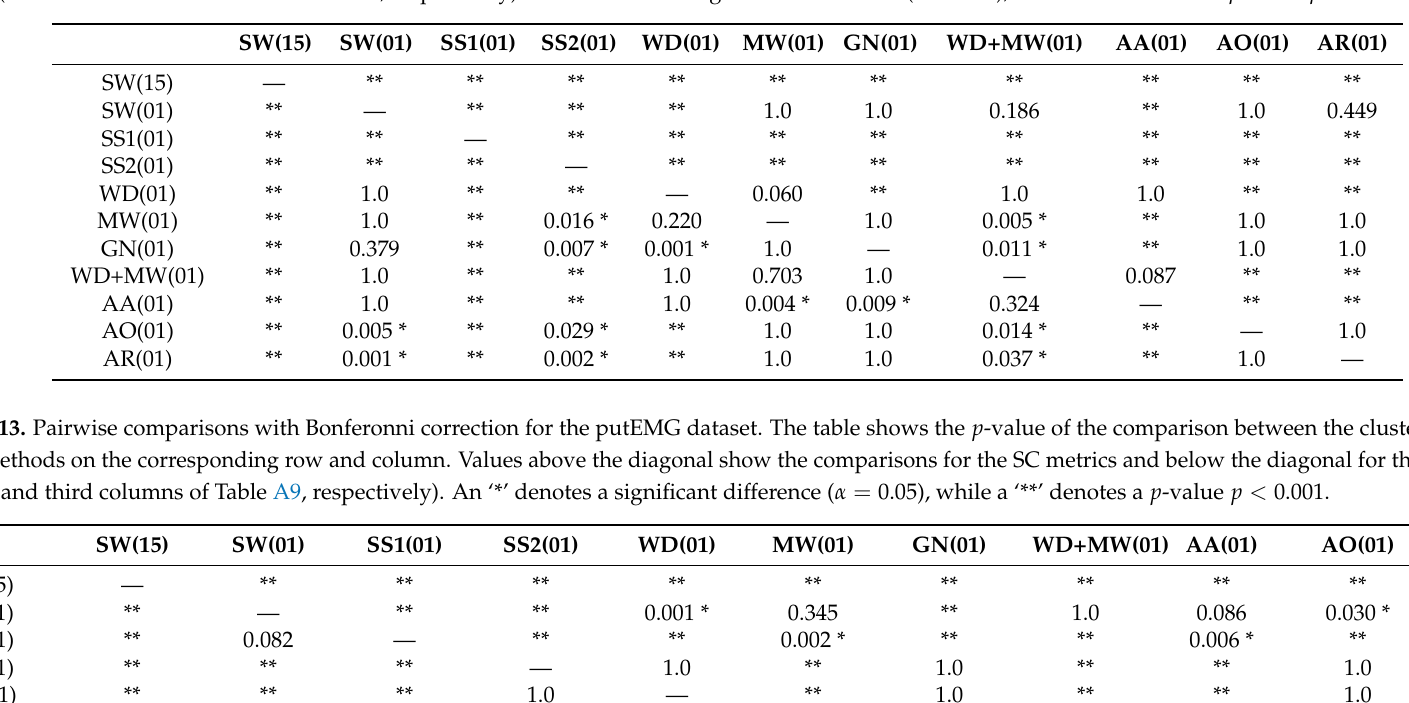
Table A12. Pairwise comparisons with Bonferonni correction for the Ninapro-DB1 dataset. The table shows the p -value of the comparison between the clustering metrics of the methods on the corresponding row and column. Values above the diagonal show the comparisons for the SC metrics and below the diagonal for the DB metrics (second and third columns of Table A8, respectively). An ‘*’ denotes a significant difference ( α = 0.05), while a ‘**’ denotes a p -value p < 0.001.